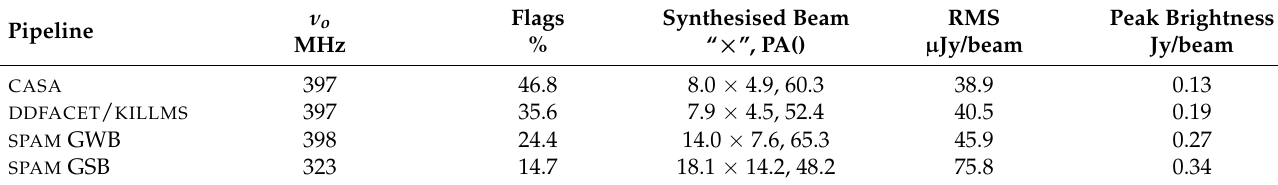
Table 1. J0034 GWB data reduction pipelines’ image comparison. Columns: (1) Name of pipeline. (2) Effective observing frequency. (3) Synthesised beam of the image. (4) Flagged data. (5) Overall rms of the full resolution images. (6) Peak brightness of the double lobed